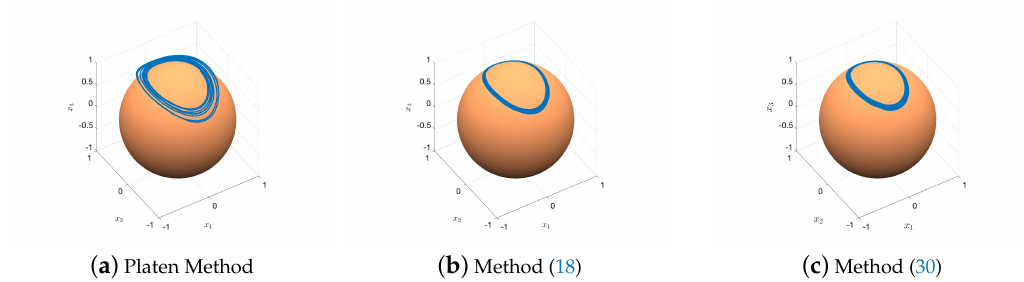
Figure 7. Numerical sample paths of the Platen method, method (18), and method (30).